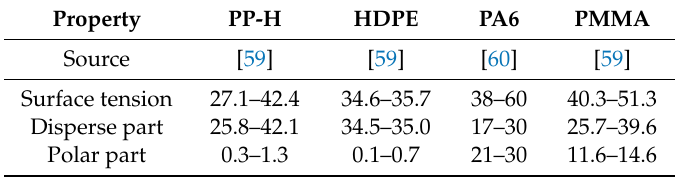
Table 5. Surface tension of the general types of materials used (literature data, Unit Nm − 1